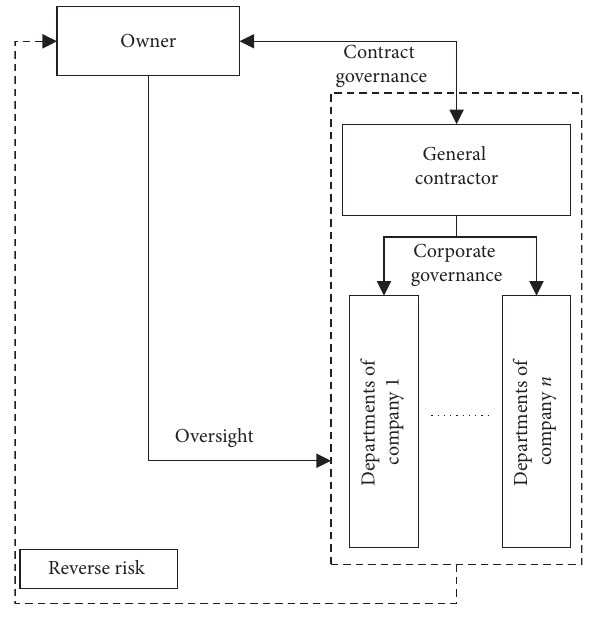
Figure 1: Hybrid governance structure in a